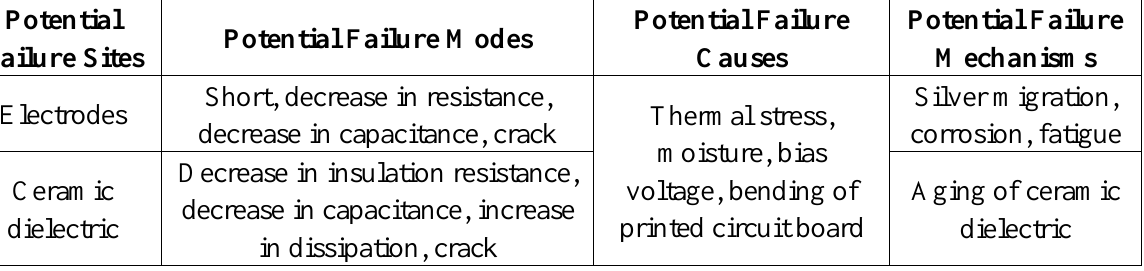
Table 2. FMMEA of the MLCC under THB